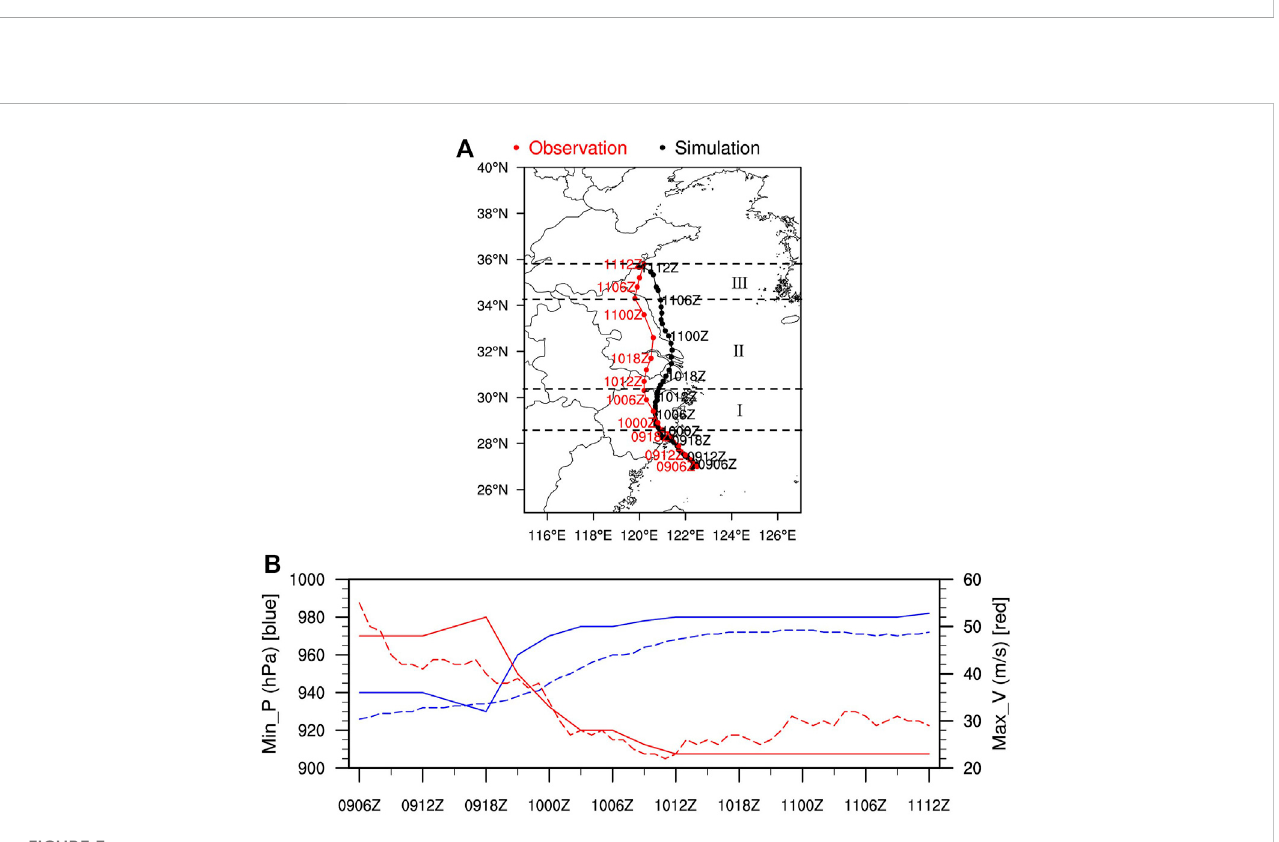
FIGURE 3 Observed and simulated tracks and intensities of Lekima from 0600 UTC 9 August to 1200 UTC 11 August 2019. (A) Observed track from the best track dataset (red line with fi lled circles denoting Lekima ’ s location every 3 h) and the simulated track from WRF (black line with fi lled circles denoting Lekima ’ s location every 1 h). Dashed lines and I, II, and III denote the three stages of the extreme rain event in Figure 4; (B) time series of the observed (solid line) and simulated (dashed line) maximum sustained 10-m wind speed (red line; unit: m/s) and minimum central sea level pressure (blue line; unit: